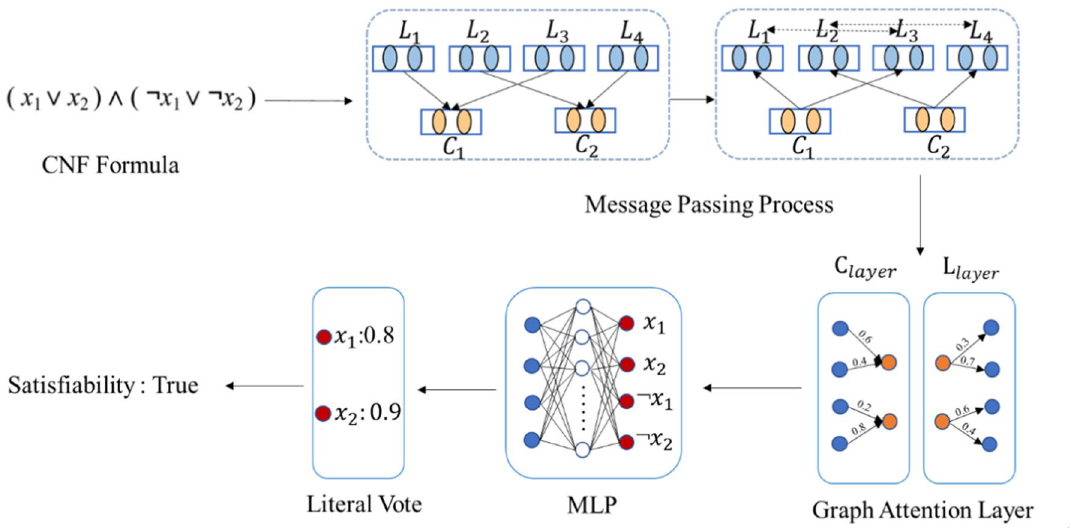
Fig. 1 The overview of our model,